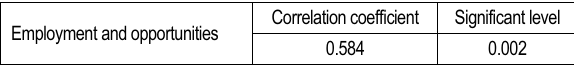
Table 5. Spearman correlation coefficient test